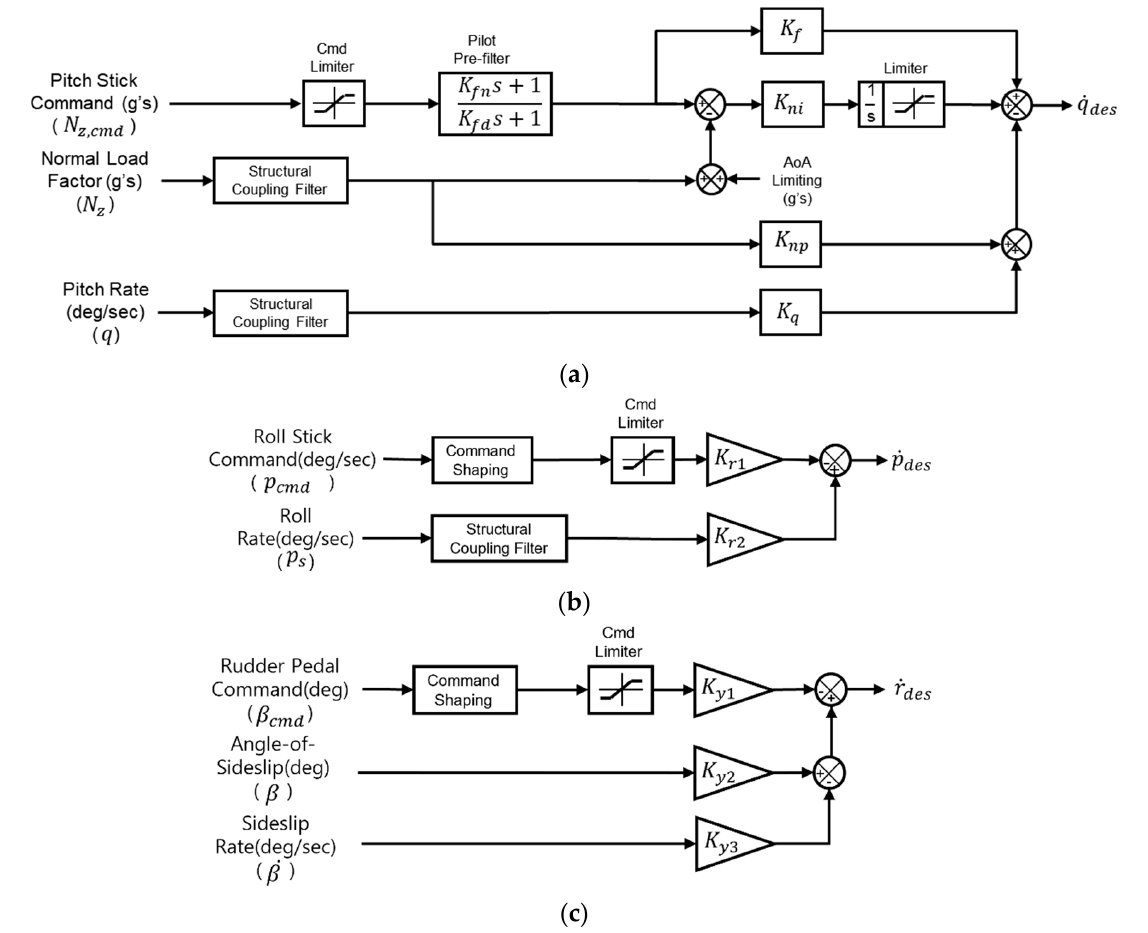
Figure 3. Control structure of desired dynamics: ( a ) longitudinal axis; ( b ) lateral axis; ( c ) directional axis [20,21].